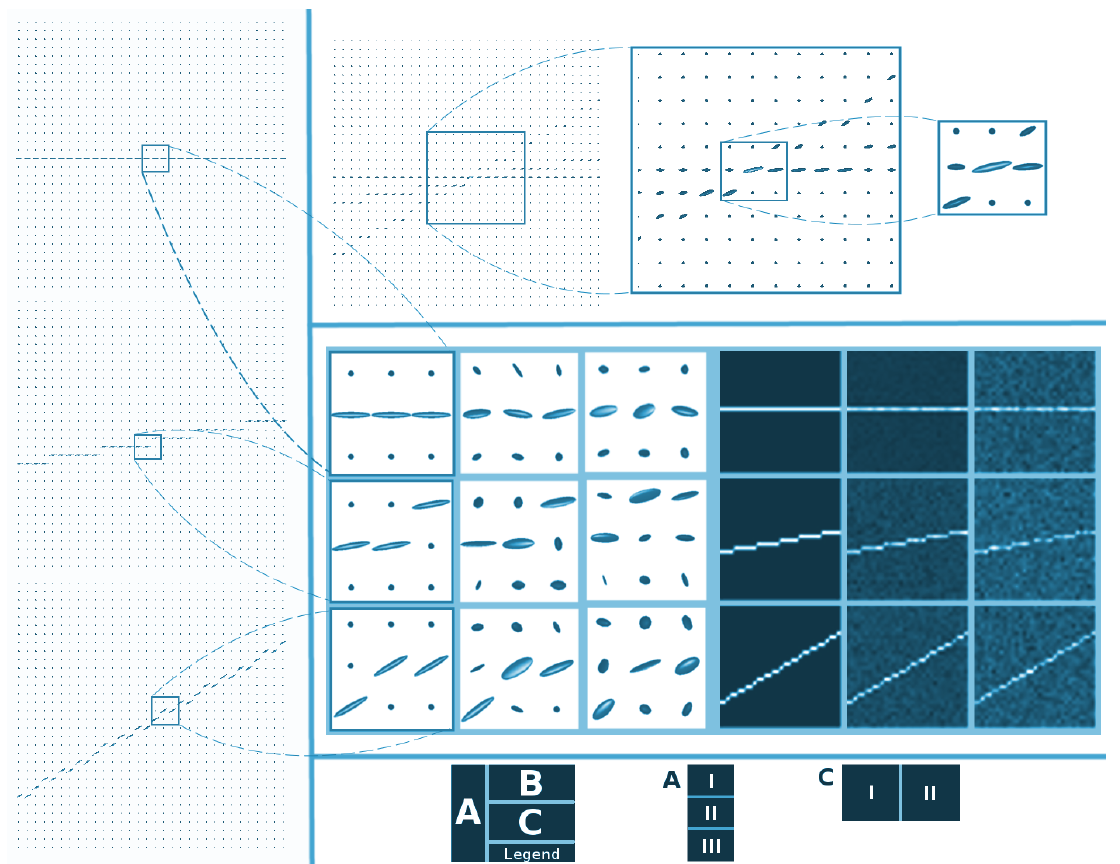
Figure 3: Proof of concept material. Panel A shows ideal-synthetic-tensor fields: A.I is the reference. A.II and A.III. are tensor fields simulating acquisition rotated 10 and 30 degrees respectively to the reference AI. Some centered tensors of Panel A are zoomed and shown in the first column of